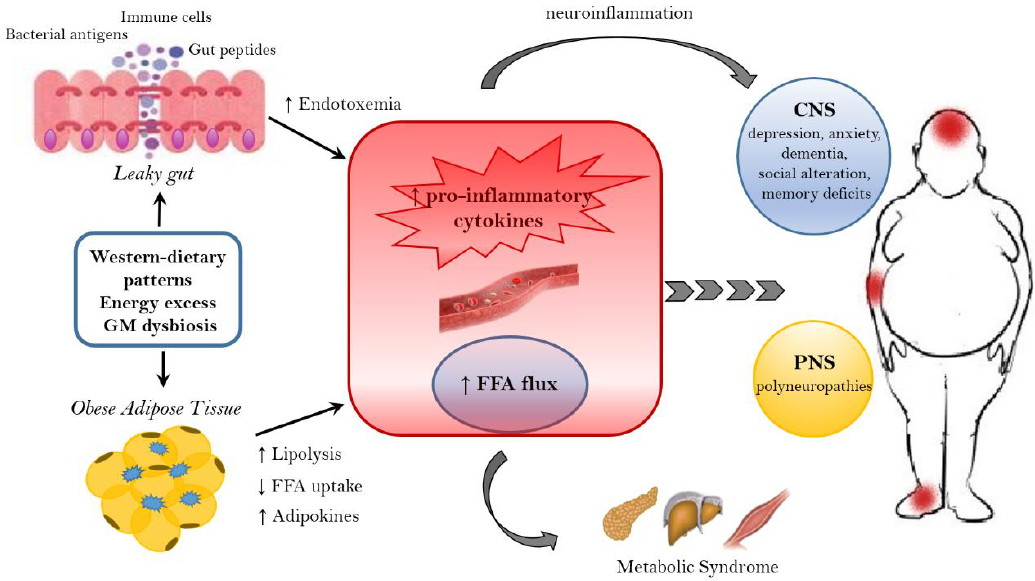
Figure 1. Mechanisms linking obesity to neurological comorbidities. Western-dietary patterns, rich in saturated fat and simple sugars, excessive food intake, and gut microbiota (GM) dysbiosis are related to obesity and its neurological comorbidities through the establishment of an inflammatory state. A dysbiotic microbiota contributes to the leaky gut syndrome, allowing the translocation of gut peptides and bacterial products that increase the peripheral inflammatory tone inducing neuroinflammation. In addition, the dysfunctional obese adipose tissue lead to the increased circulation of inflammatory cytokines, adipokines and FFA. FFA, beside the action on peripheral tissue, where they contribute to the establishment of a metabolic syndrome, have a detrimental effect on both the CNS and PNS. In the CNS, neuroinflammation and lipotoxic FFA can lead to dementia, cognitive impairment, anxiety, and depression, whereas in the PNS the end result are peripheral neuropathies. FFA = free fatty acids. CNS = Central nervous system. PNS = peripheral nervous system.